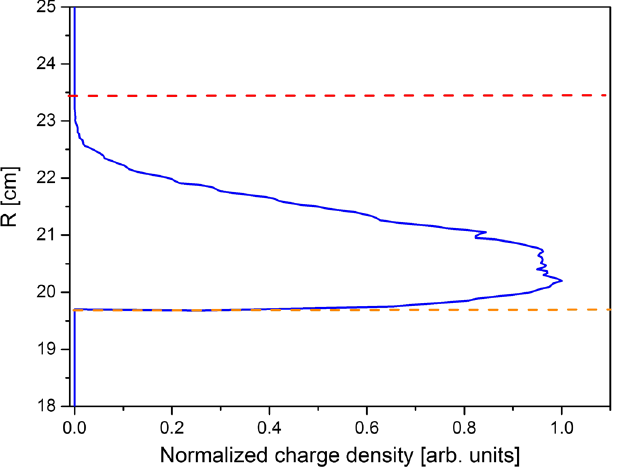
FIG. 8. Normalized average charge density for Z ranging from 210 to 310 cm at t ¼ 47 ns. The dotted orange and red lines represent the inner and outer radii of the MITL,